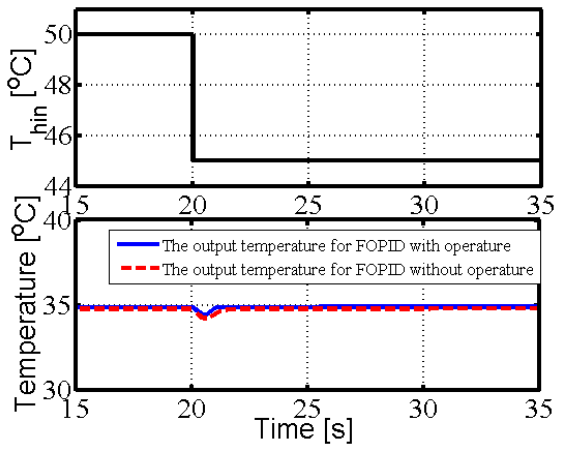
Figure 21. Antidisturbance performance to the input temperature of the hot-fluid side.